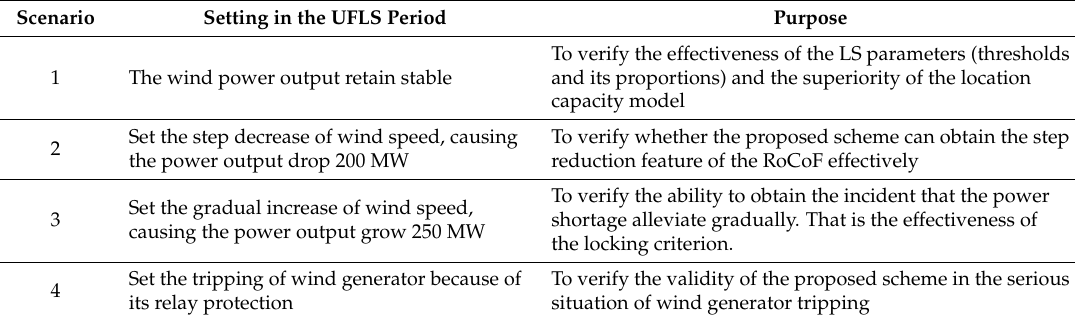
Table 1. The setup and purpose for each fault scenario.